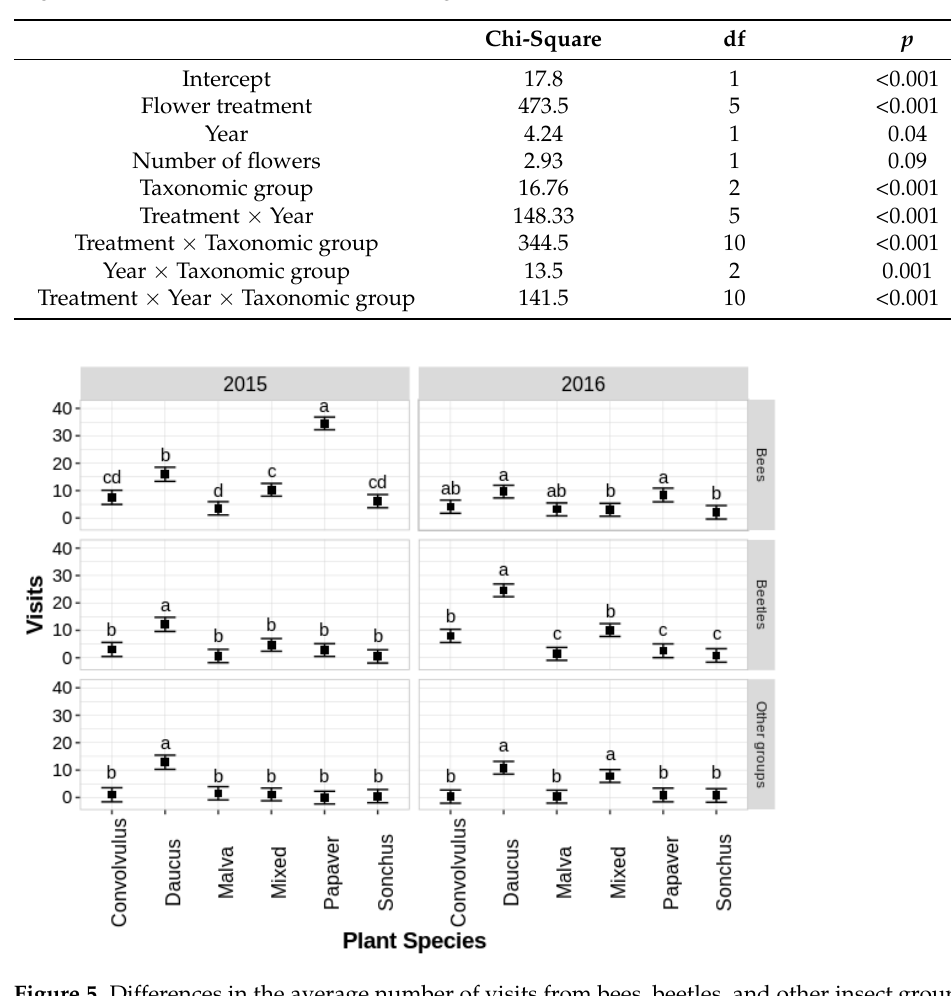
Table 2. Effects of flower treatment, year, taxonomic group, their interactions, and the average number of flowers on the average number of pollinator visits to the plots. Chi-square values and degrees of freedom (df) were derived via a general linear mixed model.